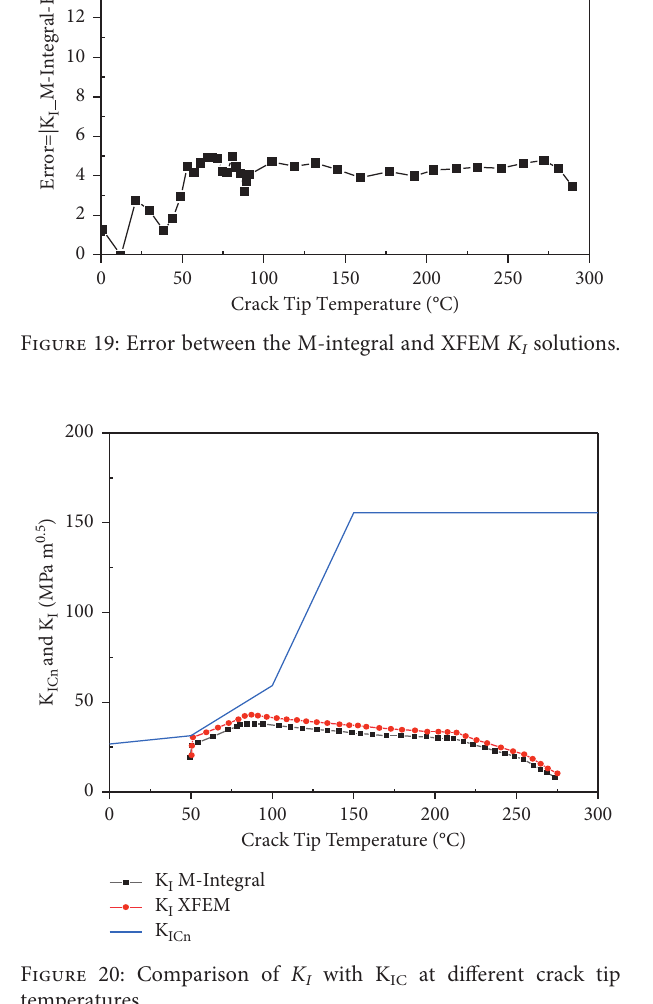
I with K IC at different crack tip